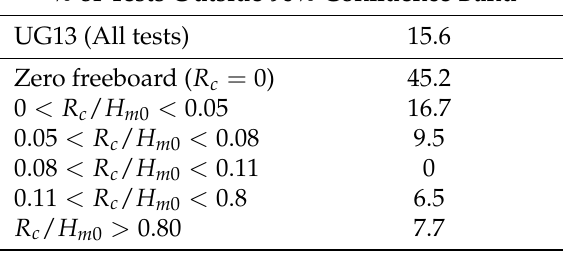
Table 7. Percentage of UG13 tests outside the 90% confidence band of the van der Meer and Bruce